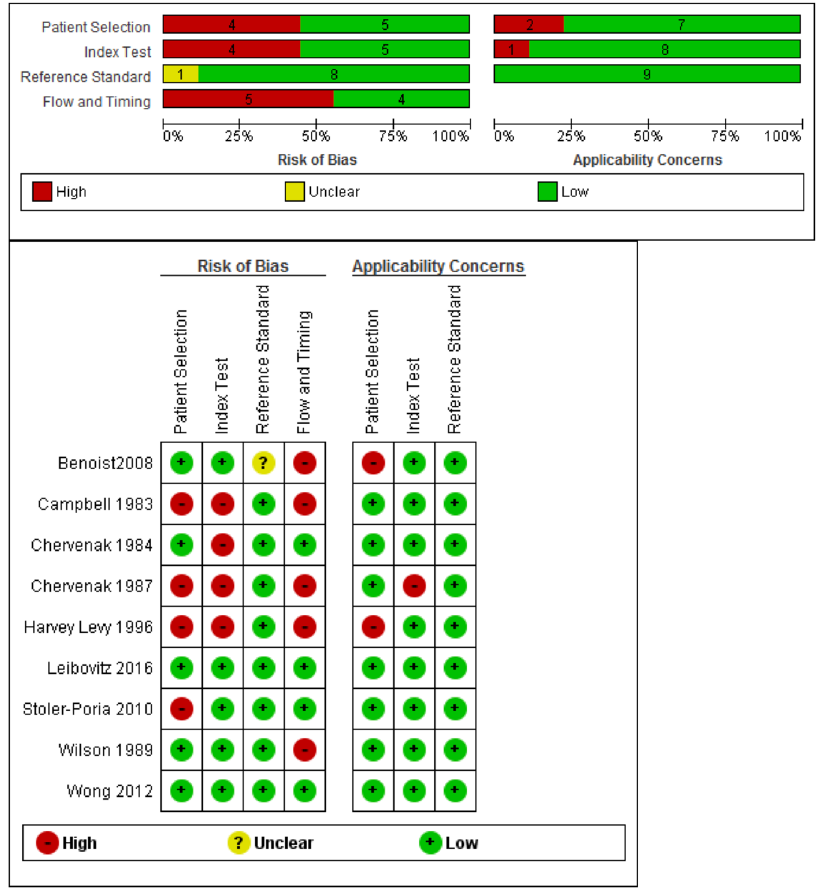
Figure 3. Quality Assessment of Diagnostic Accuracy Studies (QUADAS-2). Summary of risk of bias and applicability concerns of included